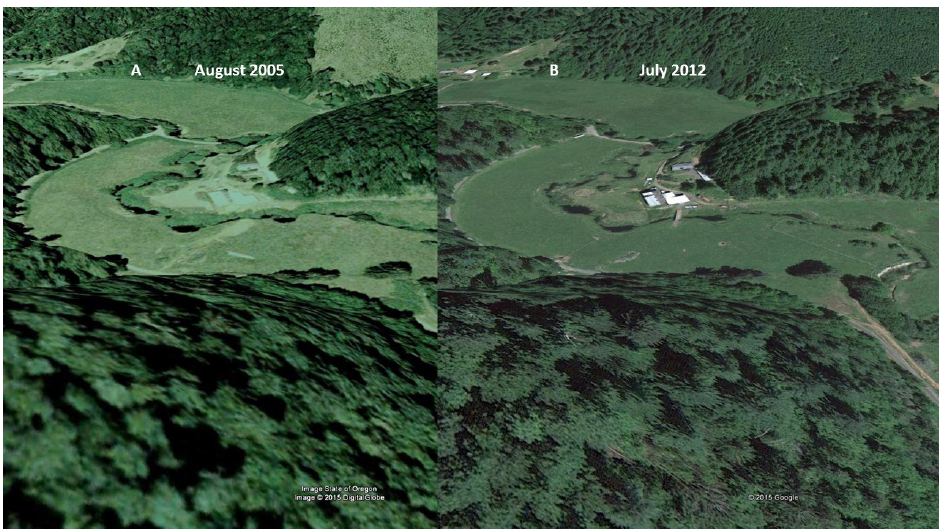
Figure 10. ( A ): August 2005 color image of the middle Roberts Creek watershed. Image shows that channel incision has migrated up into the sub-watersheds. The stream riparian area shown on the ranchland was prior to implementation of the management plan. The sub-watershed is dominated by woody plants. ( B ): USDA July 2012 color image after implementation of a natural resources management plan (fencing) for the riparian area. Some woody material has been removed. Source: State of Oregon, DigitalGlobe (2015).